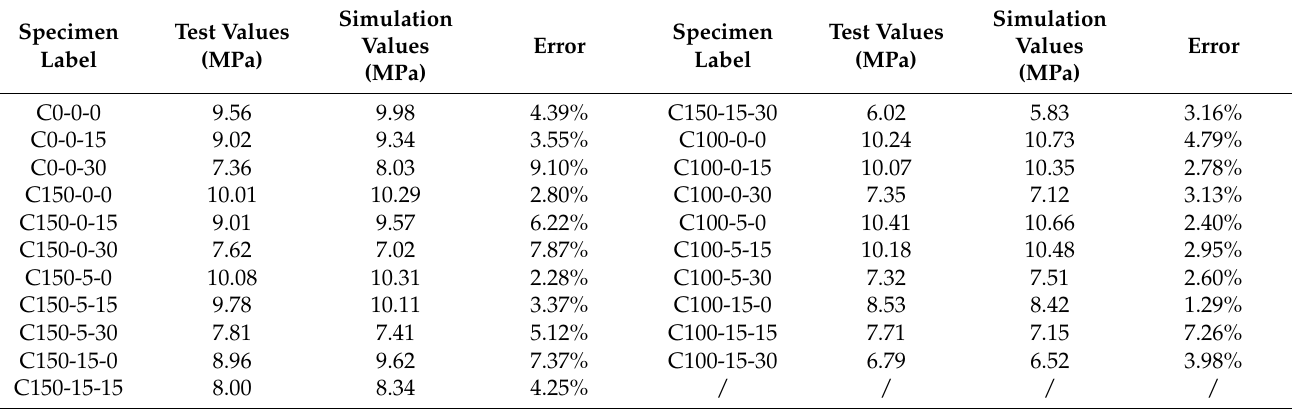
Table 11. Comparison of simulation and test results.